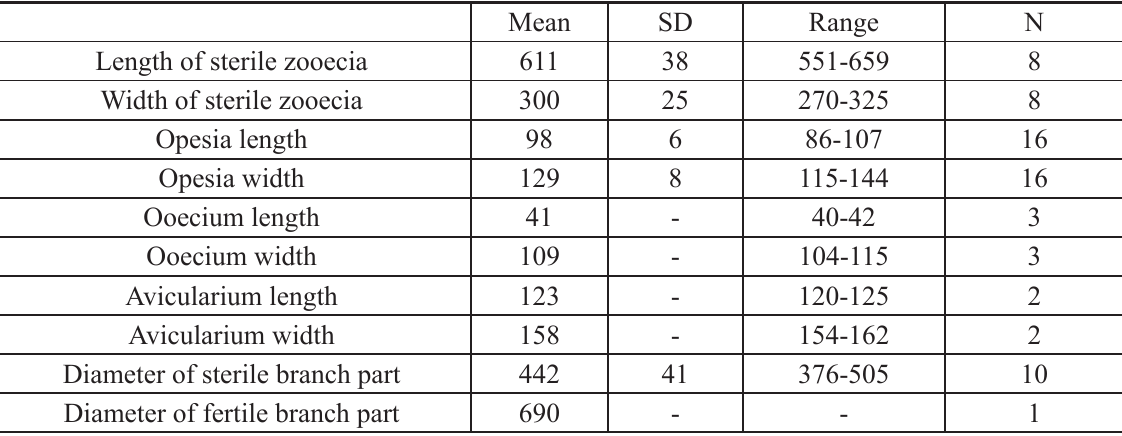
Table 2. Measurements (in µm) of skeletal characters of Cellaria harmelini d’Hondt, 1973, taken from the paralectotype (MnHn 6902). SD = standard deviation, n = number of